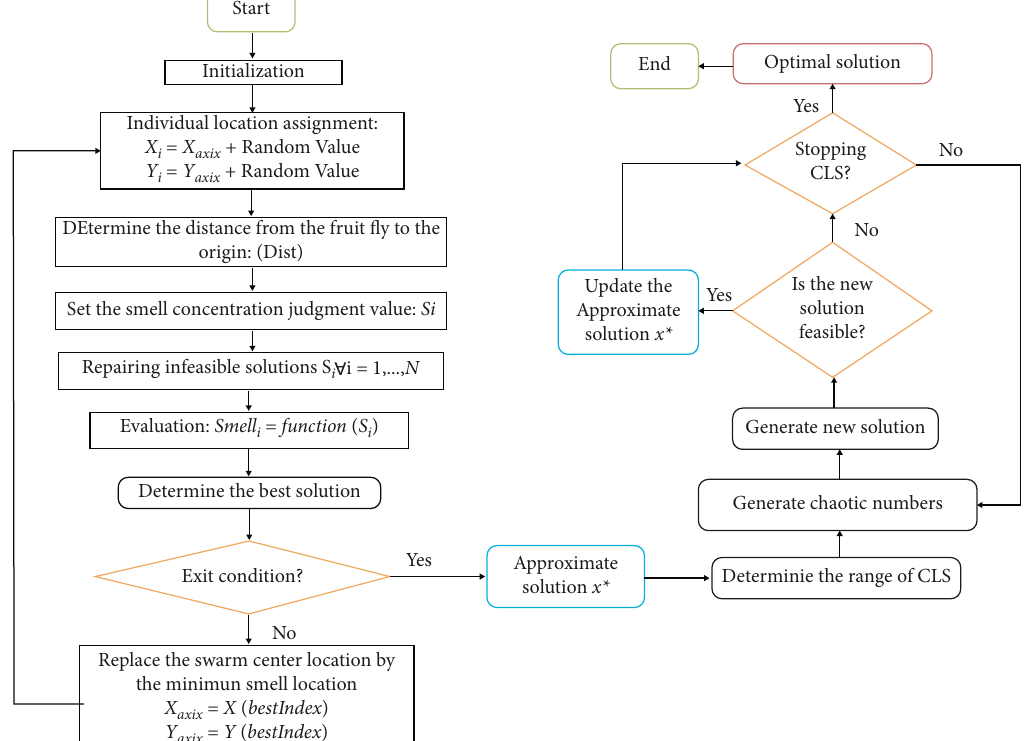
Figure 3: The suggested algorithm ′ s optimization algorithm (AOA) [120], sine-cosine moth-flame